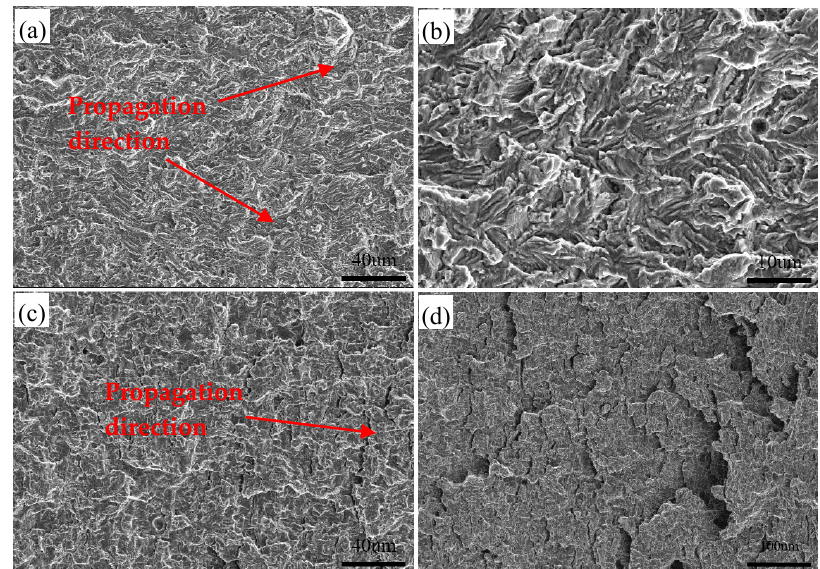
Figure 7. Typical SEM micrographs of fracture surface at peak temperature of 1350 °C. ( a ) the fracture surface in the early stage; ( b ) magnified view of the dashed box in ( a ); ( c ) the area far away from the crack source; ( d ) magnified view of the dashed box in (c).